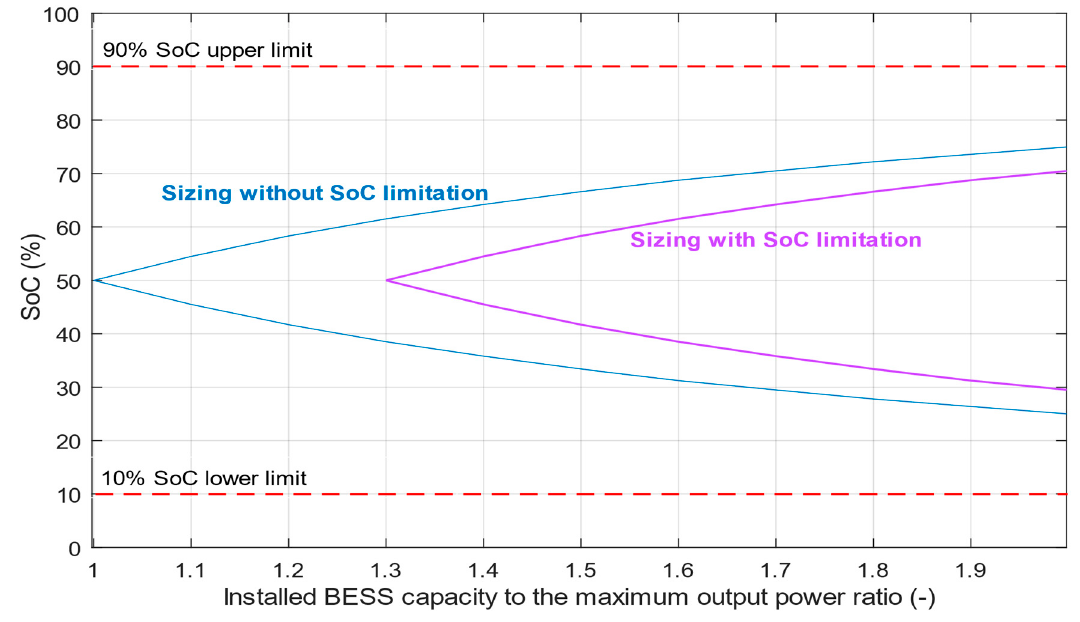
Figure 8. Permitted SoC BESS working area.